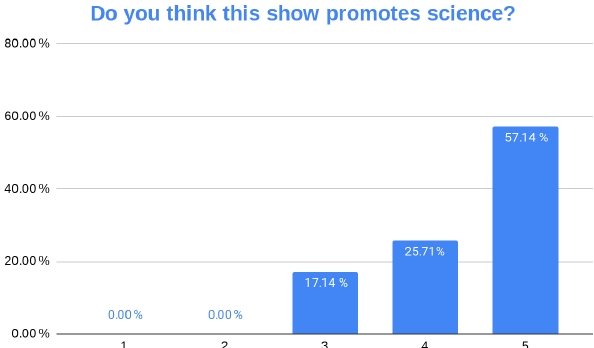
Figure 6. Plot showing the percentage of people agreeing that the play promotes science.